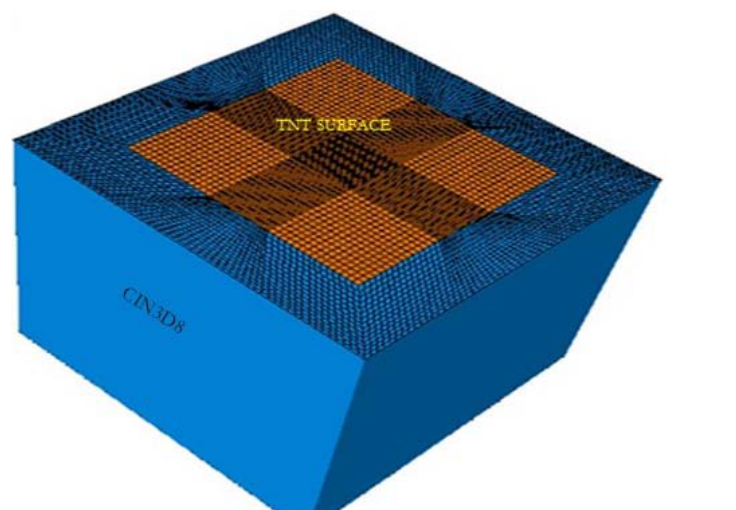
Figure 4 : 3D model in